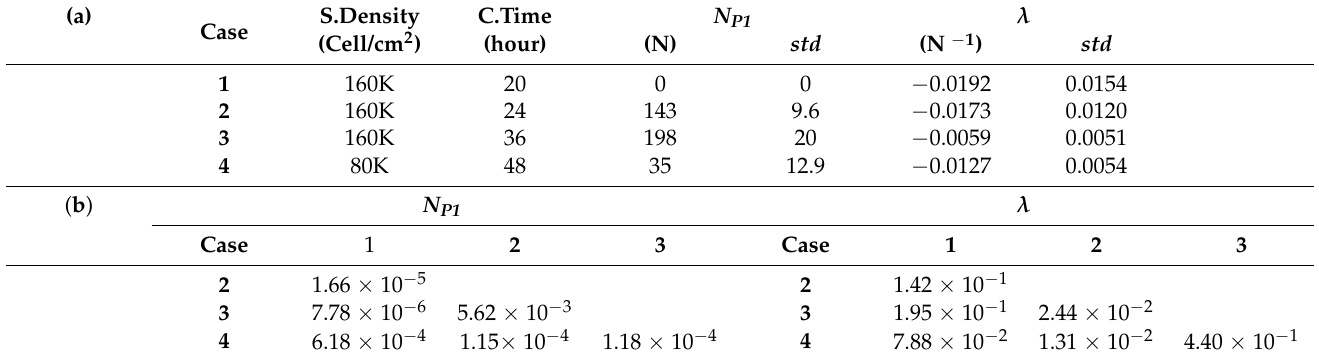
Figure 10. Schematic representation of Phase 1 and Phase 2 behavior based on functions in Table 1. Table 1. ( a ) Computed N P 1 and λ . S. Density is the seeding density, C. Time is the culture time in the flow chamber, and std is standard deviation. ( b ) p -values of corresponding case.